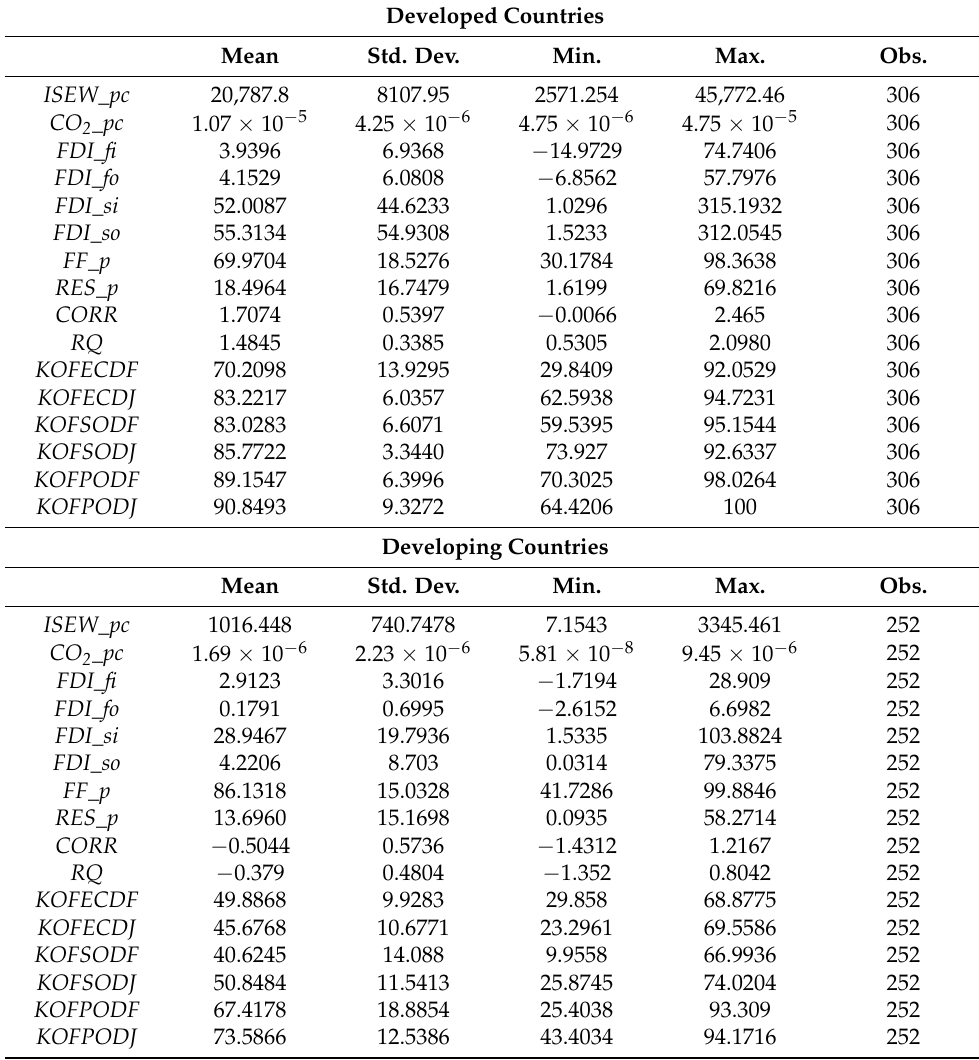
Table 4. Descriptive statistics from 2000 to 2017 (ISEW